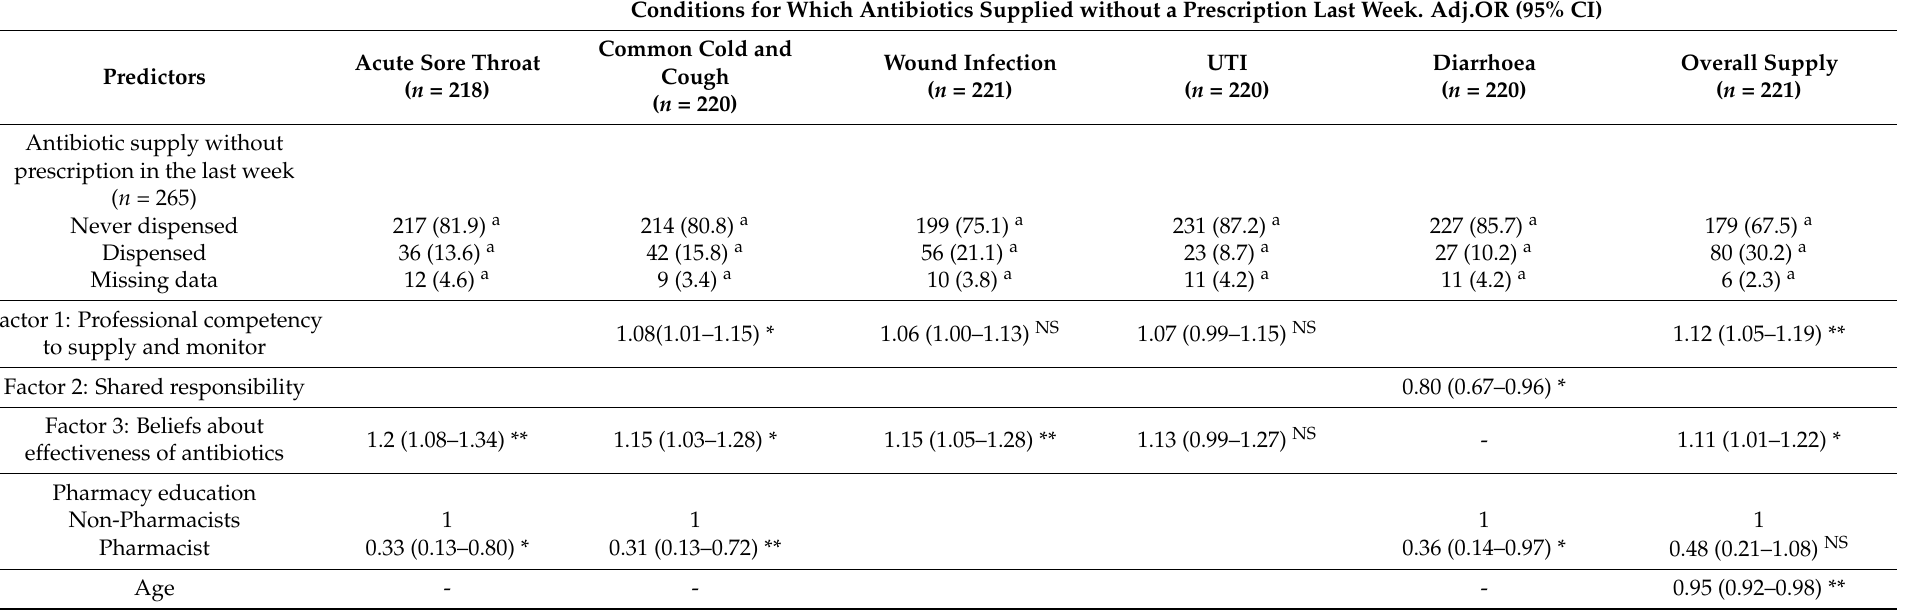
Table 4. Factors related to antibiotic supply for different